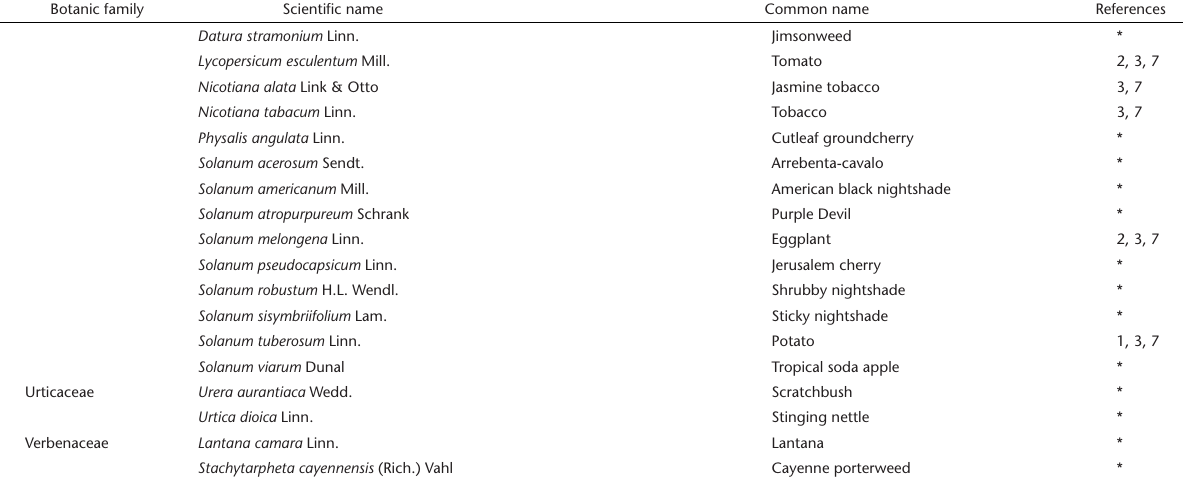
Table 5. Pupal weight (mg) of Spodoptera cosmioides reared on arti- ficial diet, including individual whose larvae underwent for six and seven instars, under controlled conditions (25 ± 1°C, 70 ± 10% RH and 14 hours of photophase). A. Student t-test considering different variances between means of females and males with six larval instars; B. Same but between females with six and seven larval instars.